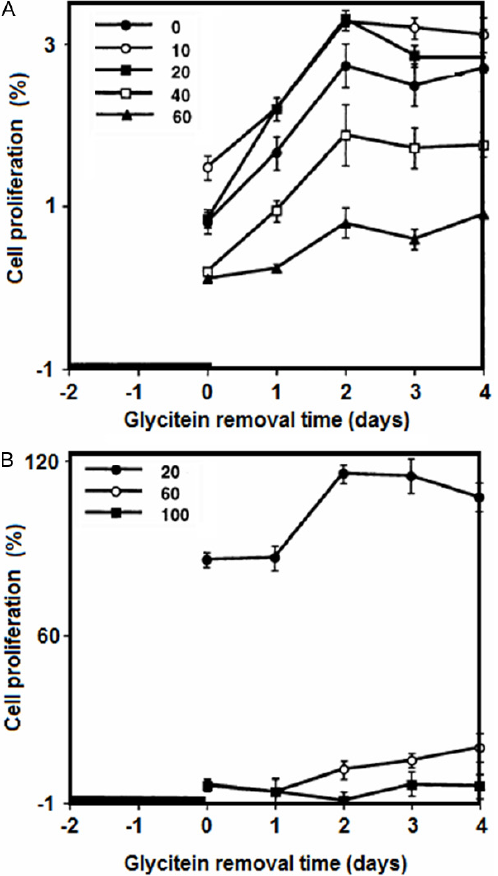
Figure 4. Reversibility in the inhibitory effect of gly- citein on cell proliferation and DNA synthesis in SKBR-3 cells. Exponentially growing SKBR-3 cells were treated with glycitein at various concentrations for 48 hours. At the end of the incubation, glycitein -containing medium was removed and cells were washed with fresh Dulbecco’s modified Eagle’s me- dium (DMEM) three times to remove any residual gly- citein. (A) Fresh phenol red-free DMEM medium sup- plemented with 10% charcoal-stripped fetal bovine serum was added and (A) cell growth and (B) DNA synthesis were measured after cells were allowed to grow for 0 to 4 days. Values are means ± SD.